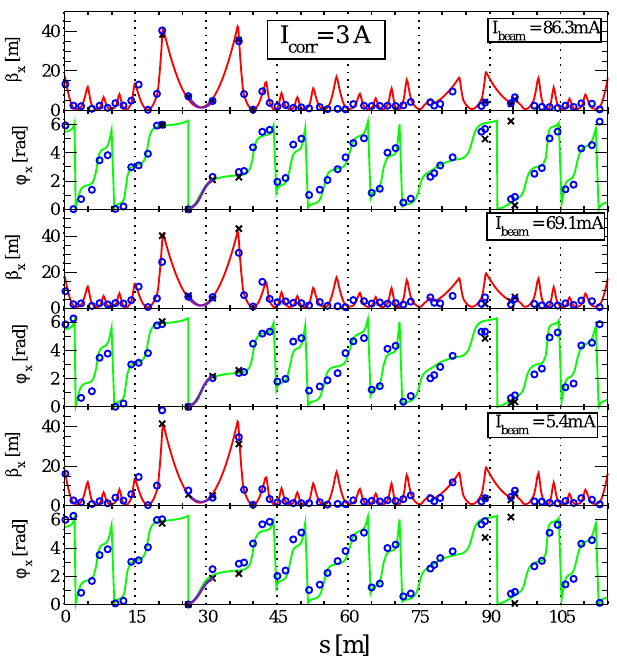
FIG. 3. Measurements of the horizontal (cid:1) function and phase for standard lattice configuration, I corr ¼ 3 A current at the corrector coils and several beam currents I beam (see legend). Shown are the theoretical (cid:1) function (red) and phase (green) taken from the given lattice model, the corresponding values from the seven multiturn BPMs (black crosses) and the results from the combined method (blue circles). In the drift space (around ’ s ¼ 30 m ), (cid:1) x and x can be obtained continuously (indigo line).